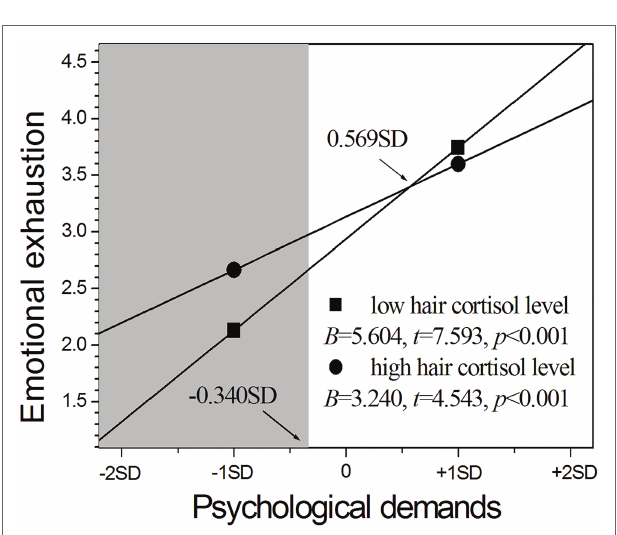
FIGURE 2 | The moderating role of hair cortisol in the relationship between psychological demands and emotional